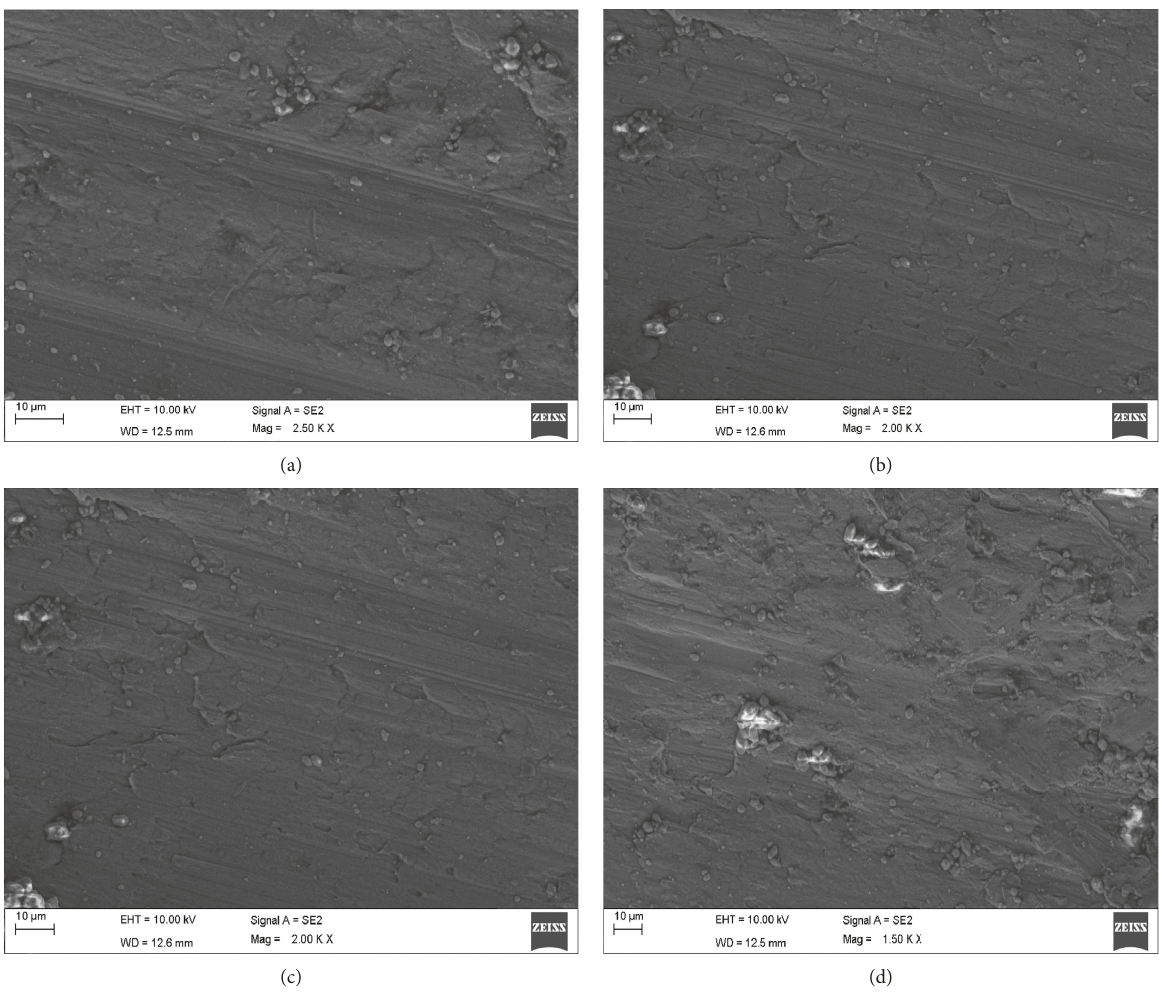
Figure 8: SEM analysis for 5% of reinforcement Al composite without glass